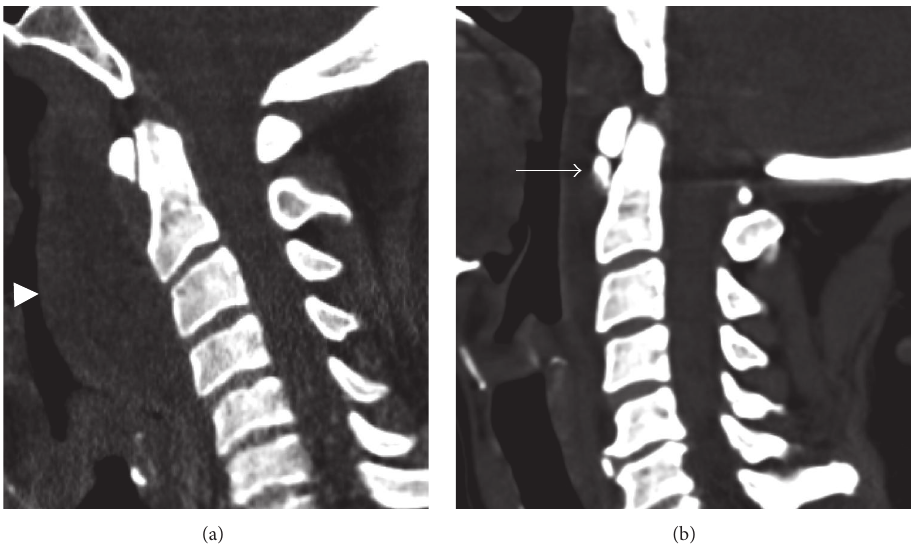
Figure17:Calcifictendinitismimickinginfection.(a)Markedretropharyngealedema(arrowhead)inapatientwithretropharyngealcellulitis. (b) Similar but less exuberant retropharyngeal edema in a patient with longus colli calcific tendinitis. The calcification of the longus colli (arrow) allows differentiation of calcific tendinitis from infection.